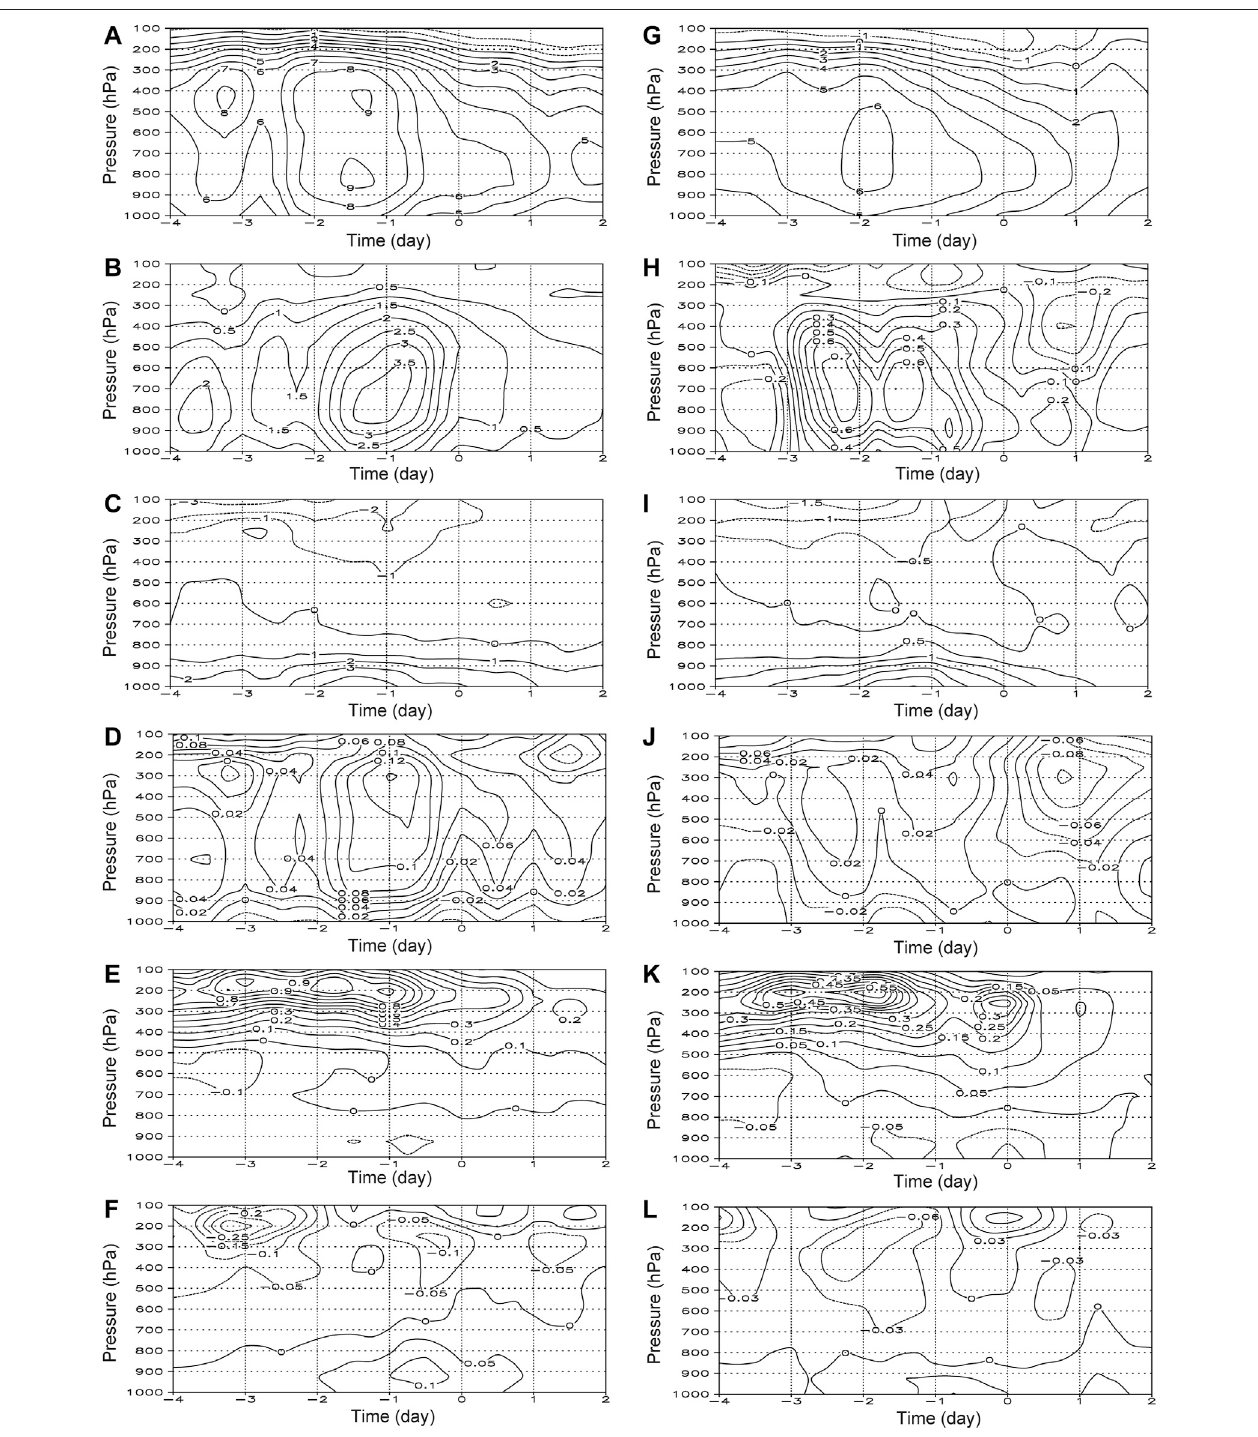
FIGURE 10 | Height – time evolution of the regional-average vorticity budget terms (units: 10 – 10 s − 2 ) in the 5 ° area near the centers of the (A – F) ERLTCs and (G – L) NERLTCs: (A,G) temporalvorticityevolution; (B,H) relativevorticityadvectionterm; (C,I) horizontaldivergenceterm; (D,J) β -effectterm; (E,K) verticaltransporttermof the relative vorticity; (F, L) tilting term.